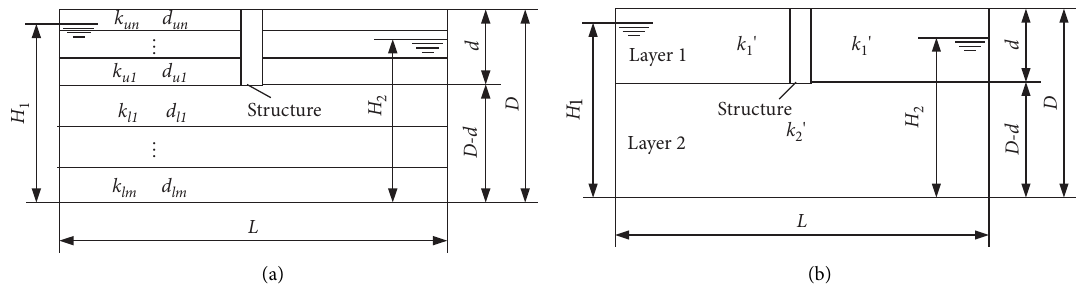
Figure 19: Multilayer soil simplifcation schematic diagram. (a) Multilayer soil diagram. (b) Simplifed two-layer soil.